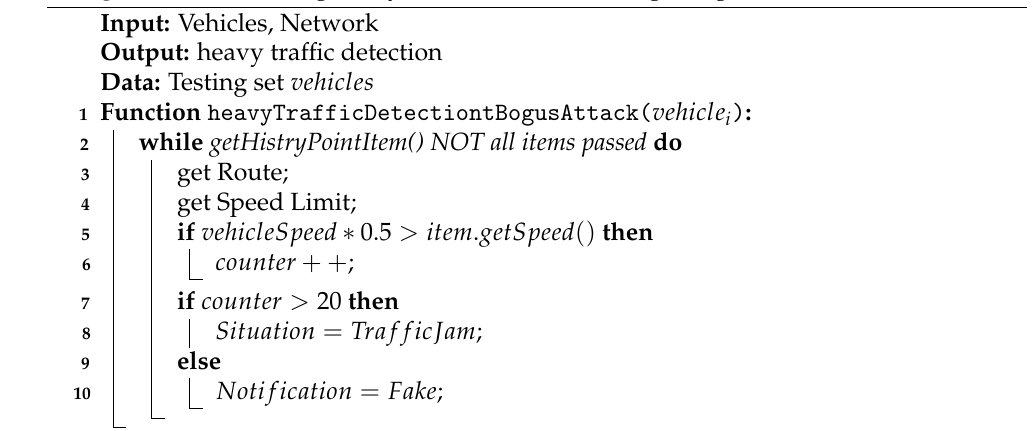
Algorithm 3: Handling heavy traffic detection during a bogus